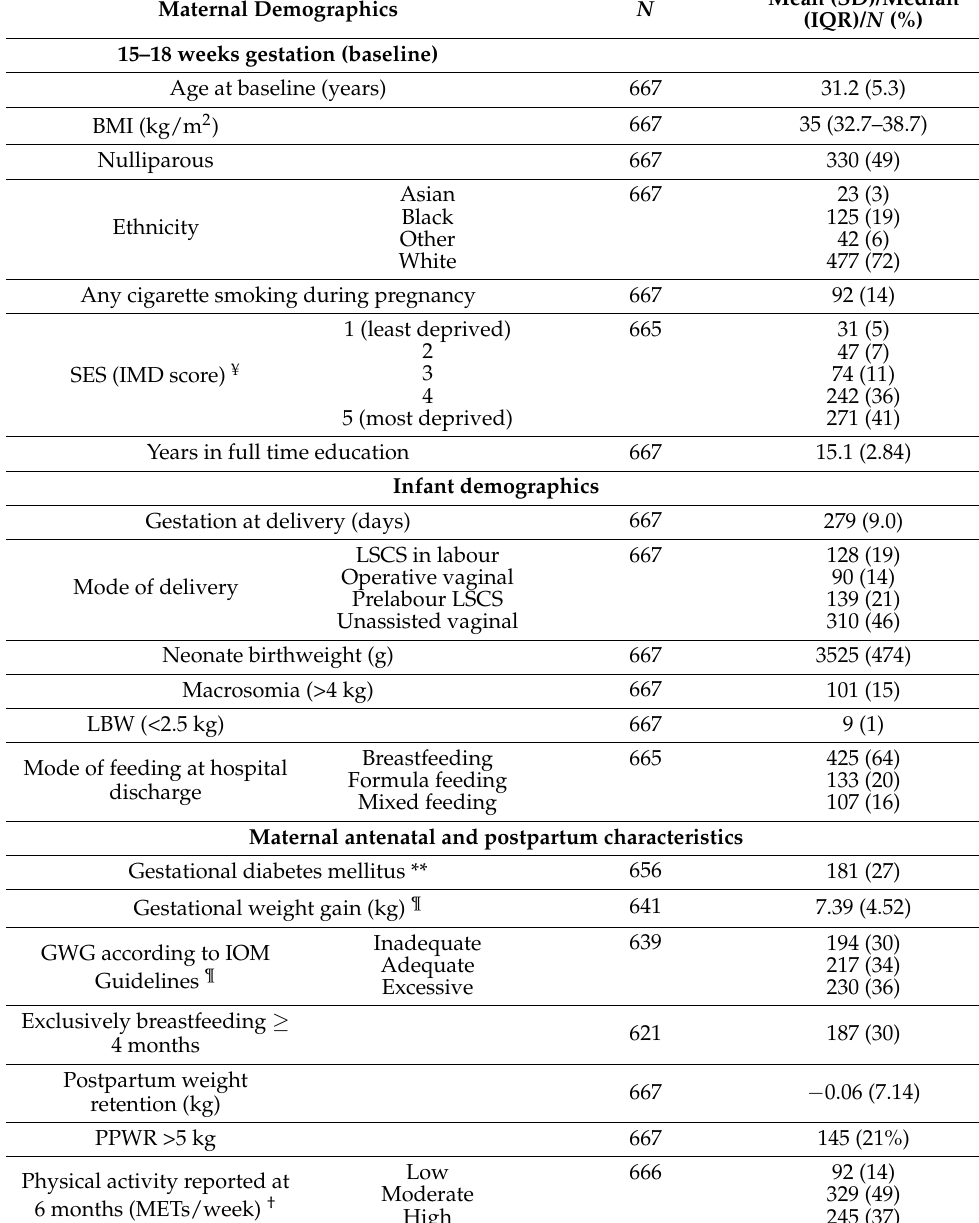
Table 1. Maternal and infant demographics included in the